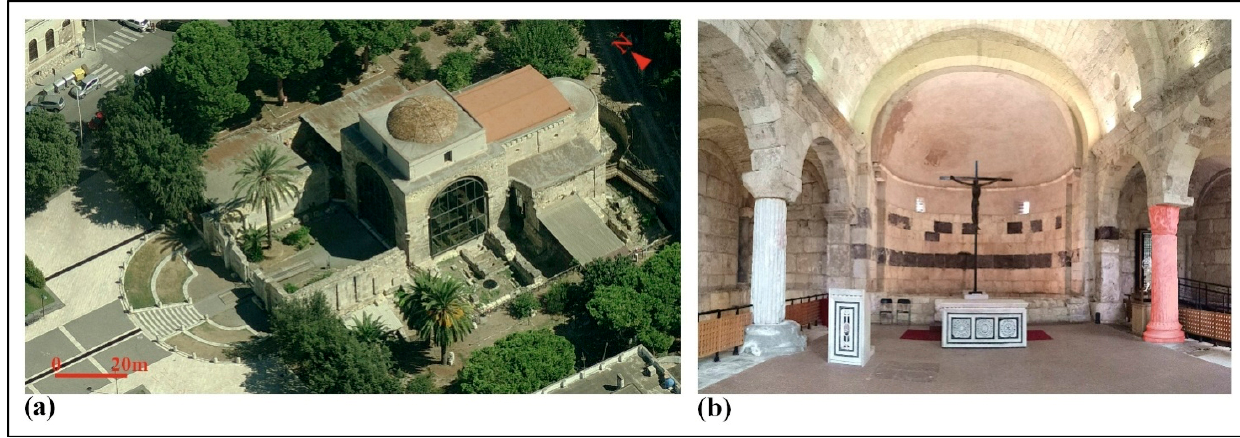
Figure 1. San Saturnino Basilica: ( a ) Panoramic image of the monument (Lat: 39.213986 North—Long: 9.123167 East modified from http://www.sardegnageoportale.it/webgis2/sardegnafotoaeree/); ( b ) central nave of the Basilica with the studied column highlighted in red.